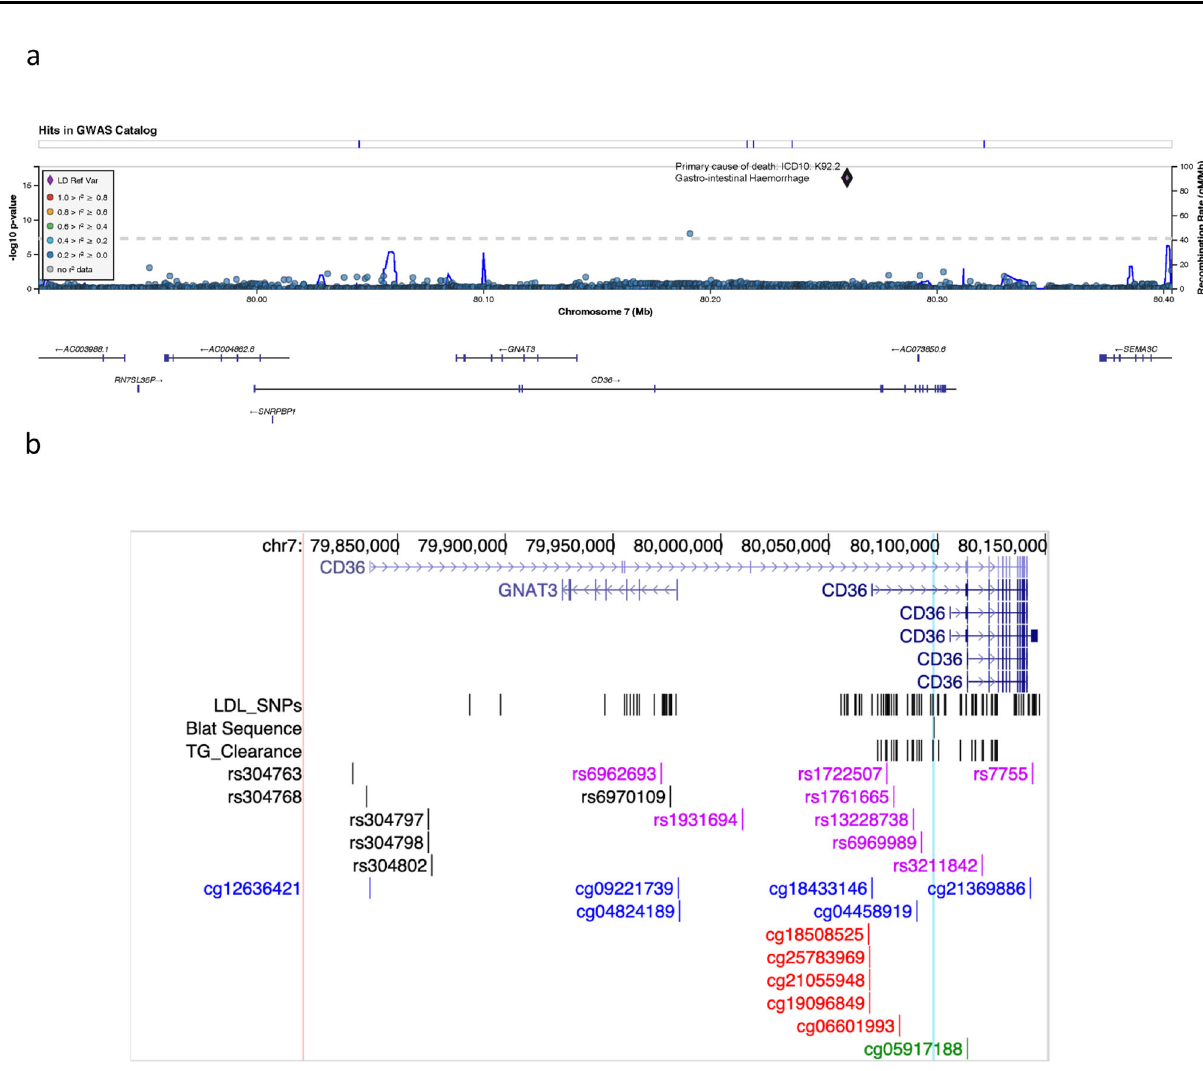
Fig. 8 Single nucleotide polymorphism rs144921258 associates with primary cause of death from gastrointestinal hemorrhage within the UK Biobank cohort. a Genomic coordinates along chromosome 7q (x-axis), with negative logarithm of p-values (y-axis) for SNP association with gastrointestinal hemorrhage p = 7.9 -17 . Location of rs144921258 in CD36 on chr7q is indicated by a diamond. The schematic of the CD36 gene below the plot also depicts the position of GNAT3, which overlaps a distal promoter of CD36. b Position of rs144921258 relative to the abundant proximal CD36 promoter 1B, (shown with its long 3 ’ untranslated region) and to SNPs previously associated with methylation at CpG sites with impact on CD36 expression and lipid handling. Red CpGs: SNP-associated methylation sites that impact CD36 expression. Purple SNPs: SNPs associated with both lipid levels and low CD36 expression. See also Table 1 and